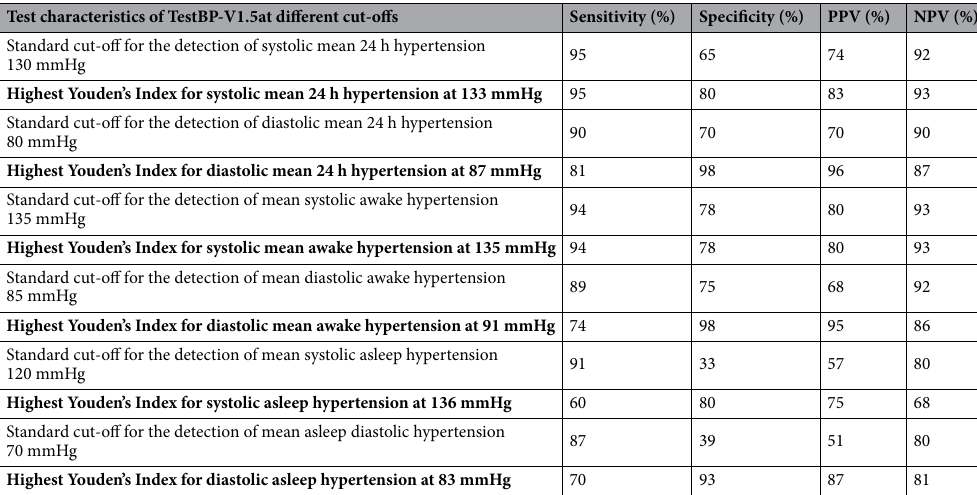
Table 6. Test characteristics for different TestBP-V1.5 values for systolic and diastolic mean 24 h, awake, and asleep. Hypertension determined by RefBP with standard cut-offs (systolic/diastolic 24mean 130/80 mmHg, awake 135/85 mmHg, asleep 120/70 mmHg) 2